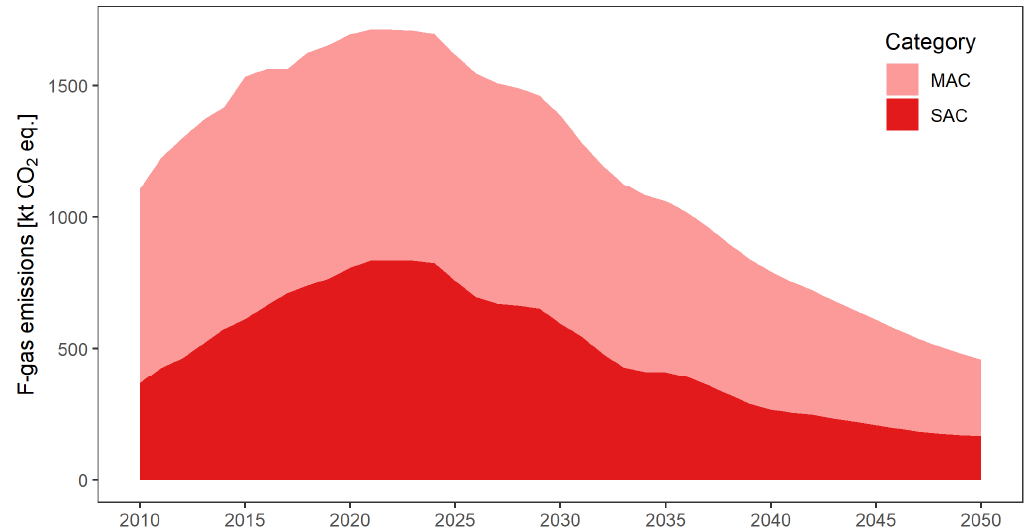
Figure 5. Trend of F-gas emission projections from air-conditioning.